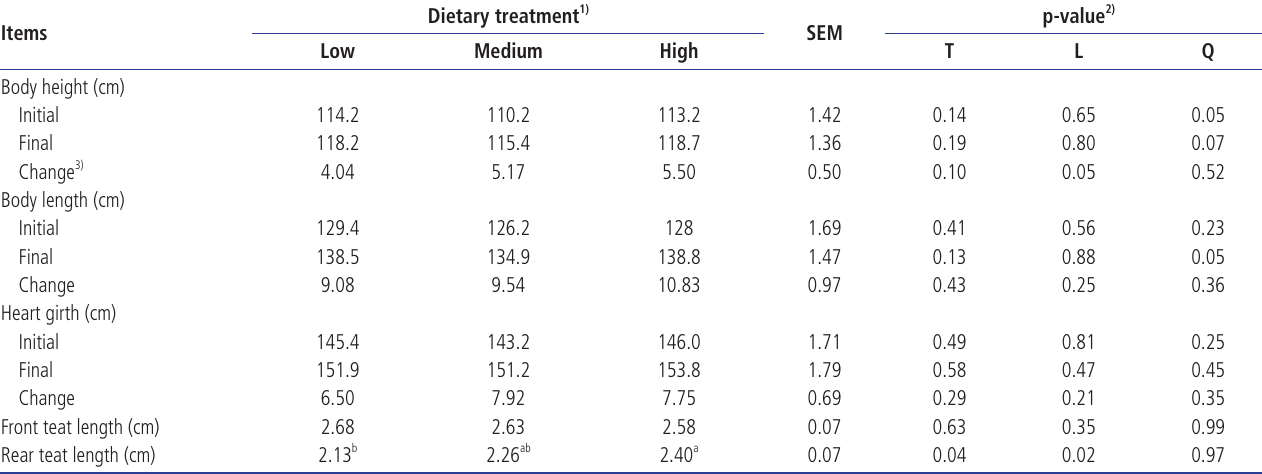
Dietary treatment 1)